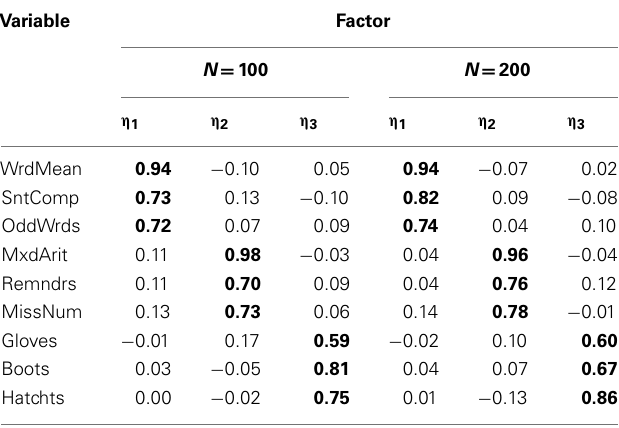
Table 8 | Factor loading matrix obtained with EFA of product-moment R among Case 2 item-level variables.